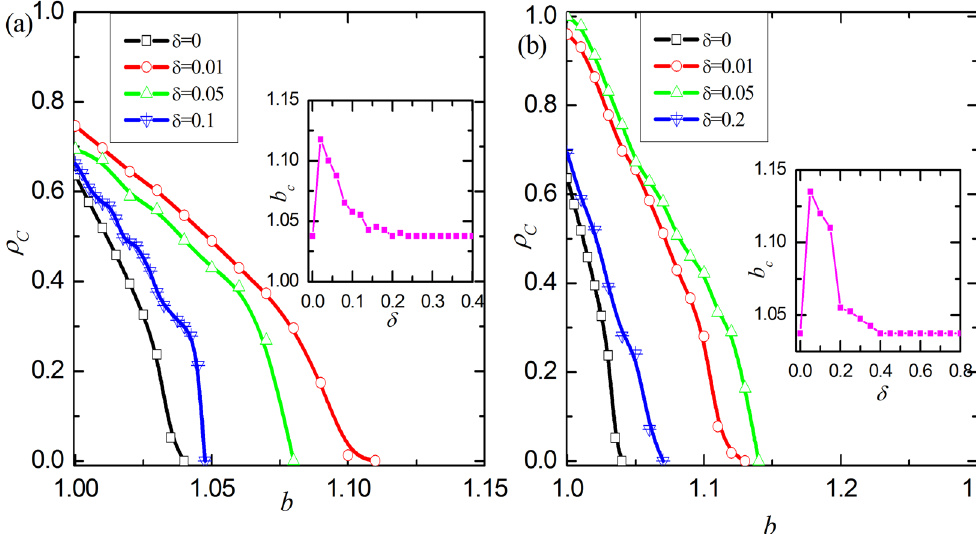
Figure 1. The fraction of cooperation ρ in dependence on the temptation to defect b for different values of δ . c ( a ) and ( b ) show the results of the case ε = . 0 4 and ε = . 0 8 . For the traditional game, i.e. δ = 0 , cooperation vanishes for small temptations. For positive δ the fraction of cooperation could be greatly enhanced and there